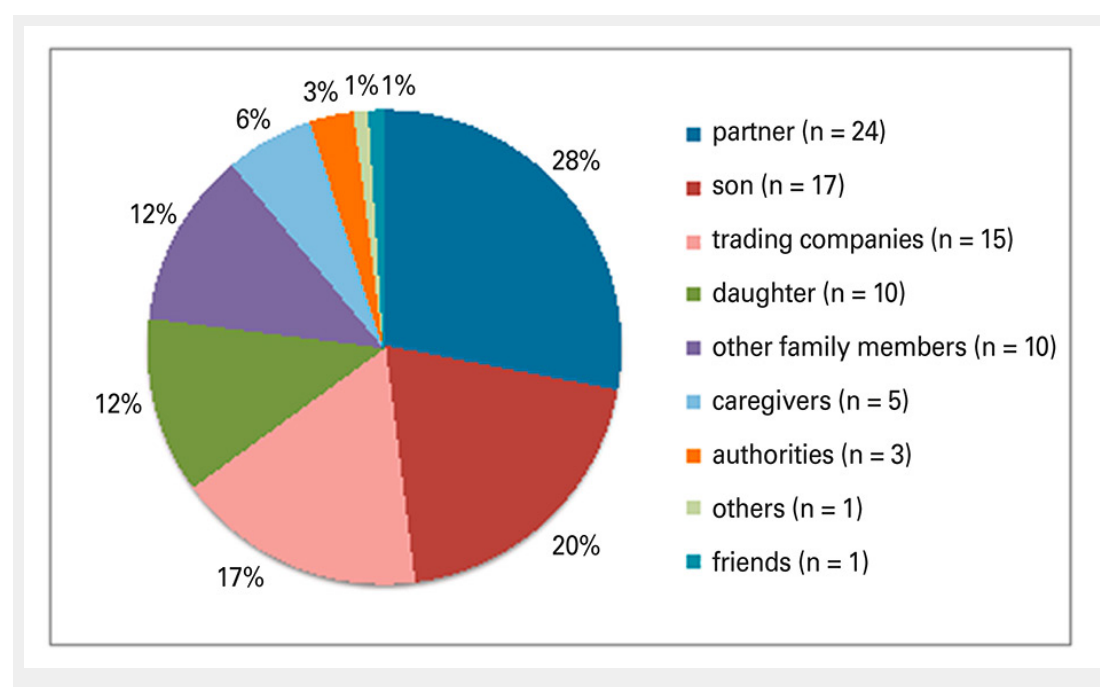
Figure 3b Perpetrators relationship to their victim (living at home, n =